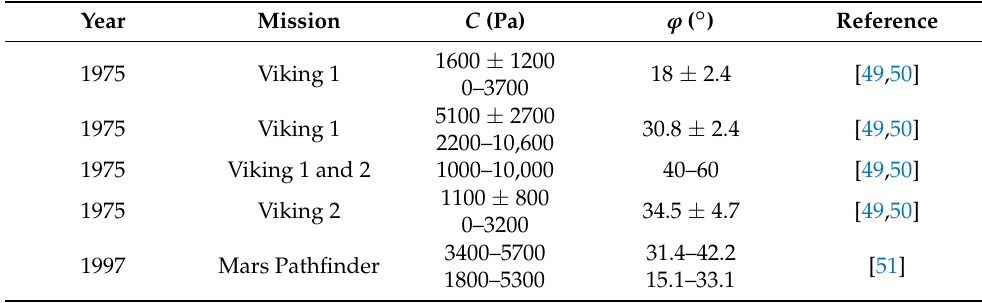
Table 2. Various sample-return missions and geotechnical characteristics of the Martian